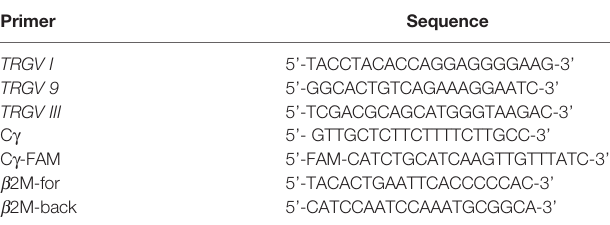
TABLE 1 | Clinical characteristics of AML patients. TABLE 2 | Sequences of primers used in RT-PCR and